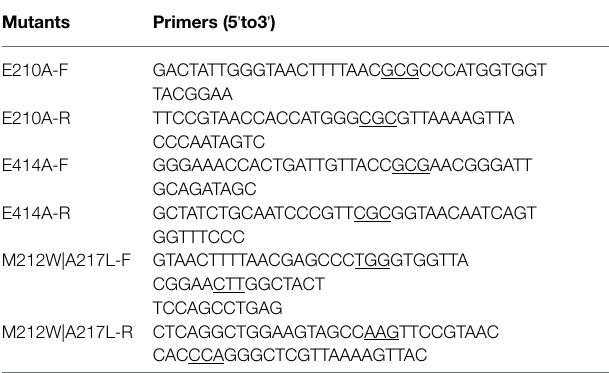
TABLE 1 | Primers used to construct the mutants of TsBGL. The mutated bases were underlined in the site-directed PCR primers. Mutants Primers (5 ' to3 ' ) E210A-F GACTATTGGGTAACTTTTAACGCGCCCATGGTGGT TACGGAA E210A-R TTCCGTAACCACCATGGGCGCGTTAAAAGTTA CCCAATAGTC